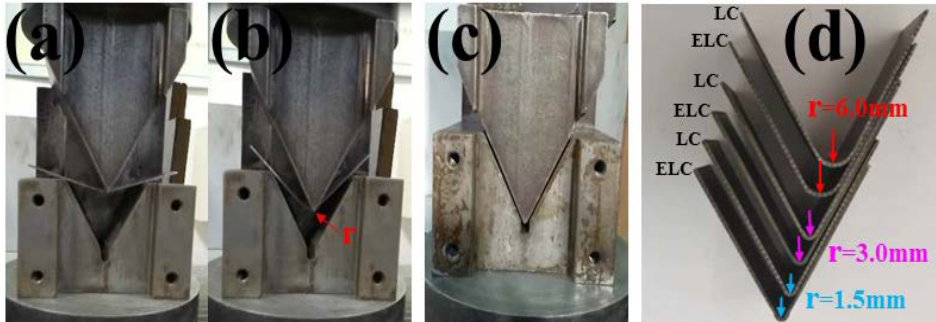
Figure 17. V-shaped bending process and bended parts with different C content: ( a ) 150°, ( b ) 100°, ( c ) 60°, ( d ) bended parts.